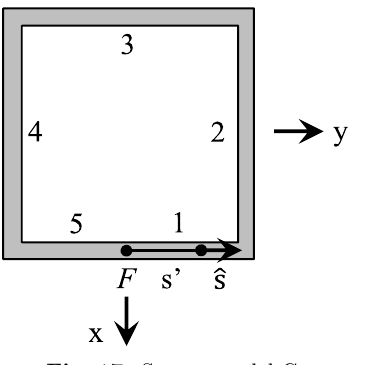
Fig. 17. Square model-C.